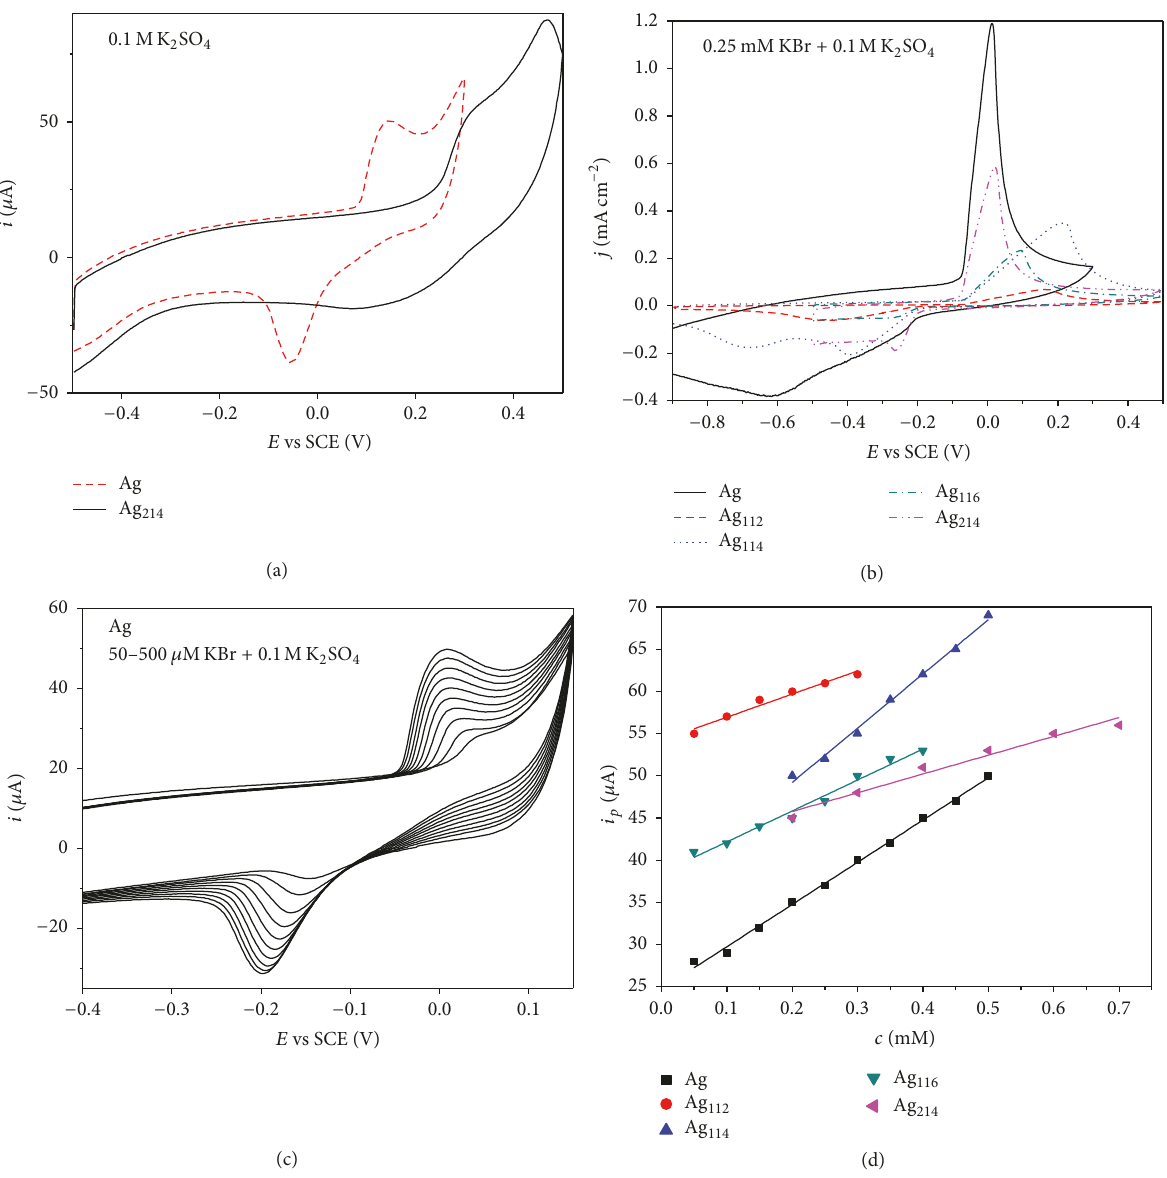
Figure 5: (a) CVs of Ag and Ag 214 /C catalyst in 0.1 M K 2 SO 4 solution at scan rate of 100 mVs −1 ; (b) CVs of all five catalysts in 0.25 mM KBr + 0.1 M K 2 SO 4 at scan rate of 100 mVs −1 ; (c) CVs of Ag catalyst in 0.1M K 2 SO 4 as supporting electrolyte with increasing KBr concentration from 0.05 to 0.5 mM at scan rate of 10mVs −1 ; (d) oxidation peak current as a function of KBr concentration for all five